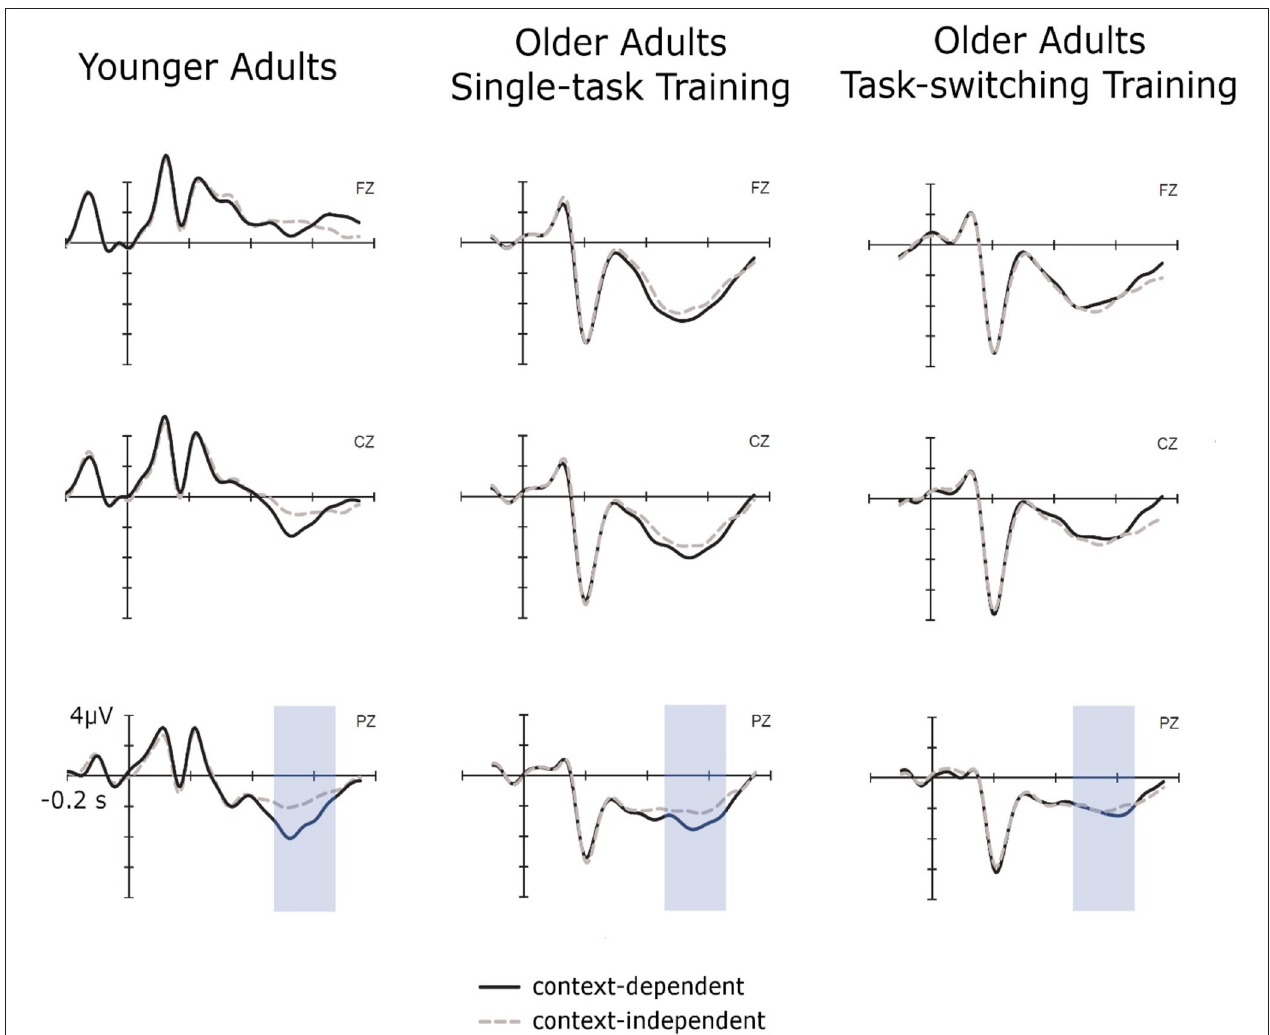
FIGURE 2 | Cue-locked ERPs for context-independent and context-dependent trials at pretest for younger adults, older adults in the single-task training group, and older adults in the task-switching training group displayed at electrodes Fz, Cz, and